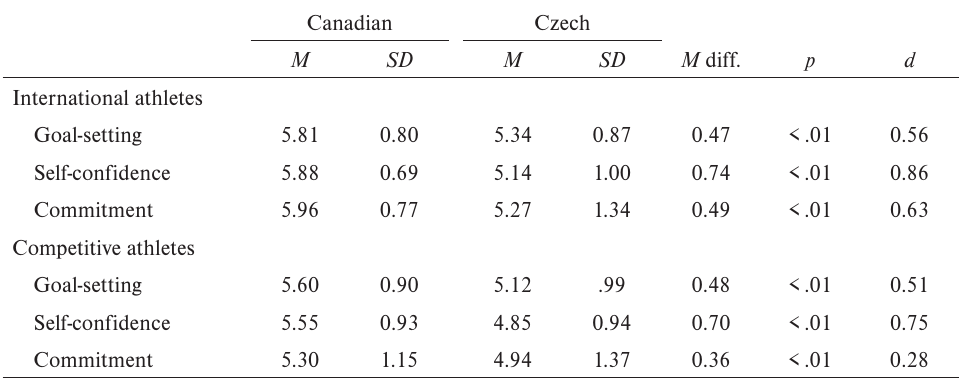
Table 4 Comparison of selected mental skills of the Canadian and Czech populations Canadian